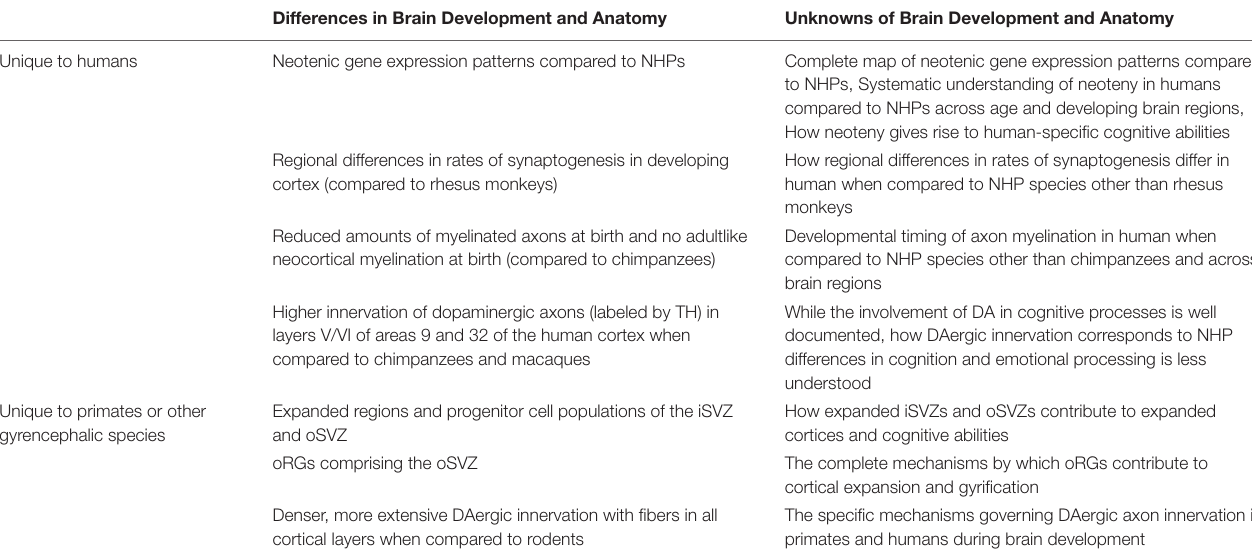
TABLE 1 | Summary of some of the known and unknown aspects of human and NHP brain development and anatomy. Differences in Brain Development and Anatomy Unknowns of Brain Development and Anatomy Unique to